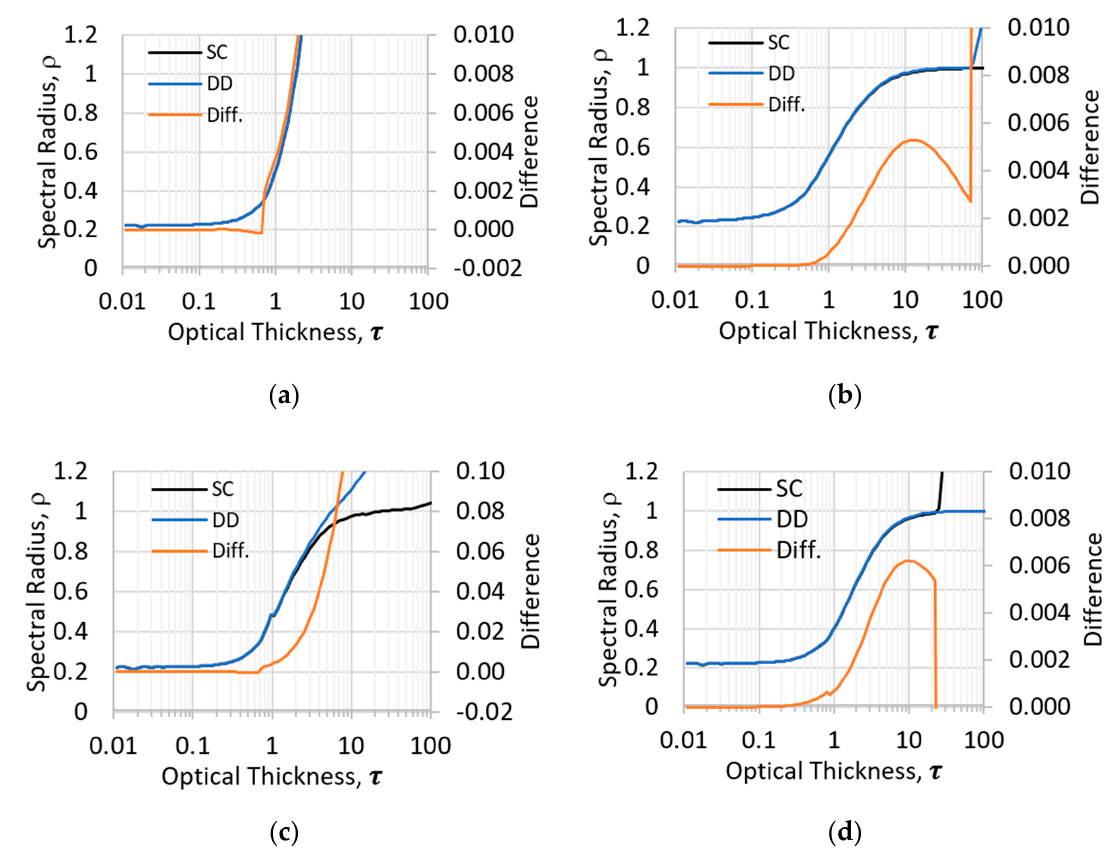
Figure 1. Spectral radius vs. optical thickness for the k-eigenvalue case. ( a ) Coarse-mesh finite difference (CMFD); ( b ) partial current-based CMFD (pCMFD); ( c ) optimally diffusive CMFD (odCMFD); ( d ) linear prolongation-based CMFD (lpCMFD).